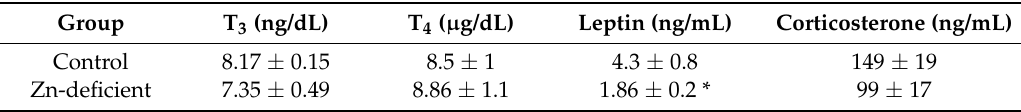
Table 1. Hormones serum concentrations of Zn-deficient and control pups at weaning. Group T 3 (ng/dL) T 4 ( µ g/dL) Leptin (ng/mL) Corticosterone (ng/mL) Control 8.17 ± 0.15 8.5 ± 1 4.3 ± 0.8 149 ± 19 Zn-deficient 7.35 ± 0.49 8.86 ± 1.1 1.86 ± 0.2 * 99 ±